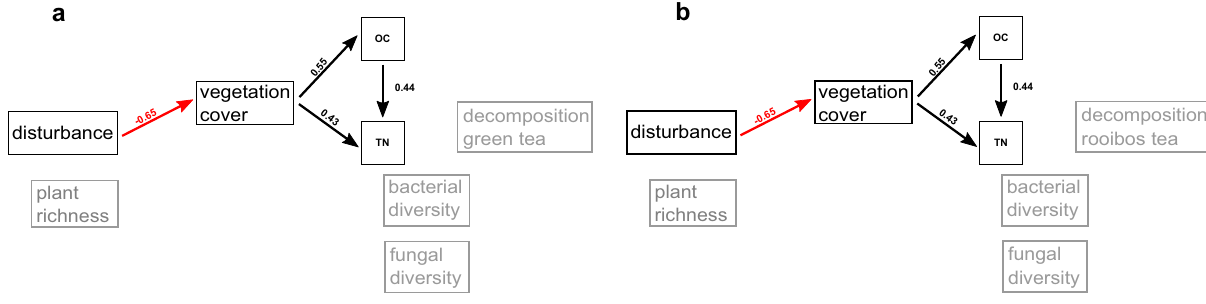
Figure 7. Structural equation models for the sampling year 2017. Subfigures show results for different soil functions as terminal response variable: decomposition of green tea ( a ), decomposition of rooibos tea ( b ). Arrows show direction of significant effects at p < 0.05, line color indicates sign of relationship (black: positive, red: negative). Double-headed arrows indicate bi-directional correlation. Standardized coefficients are given as numbers next to the arrows. Marginal R 2 -values of soil functions are given for microbial diversity and soil functions. Variables with no significant pathway are shaded in grey.